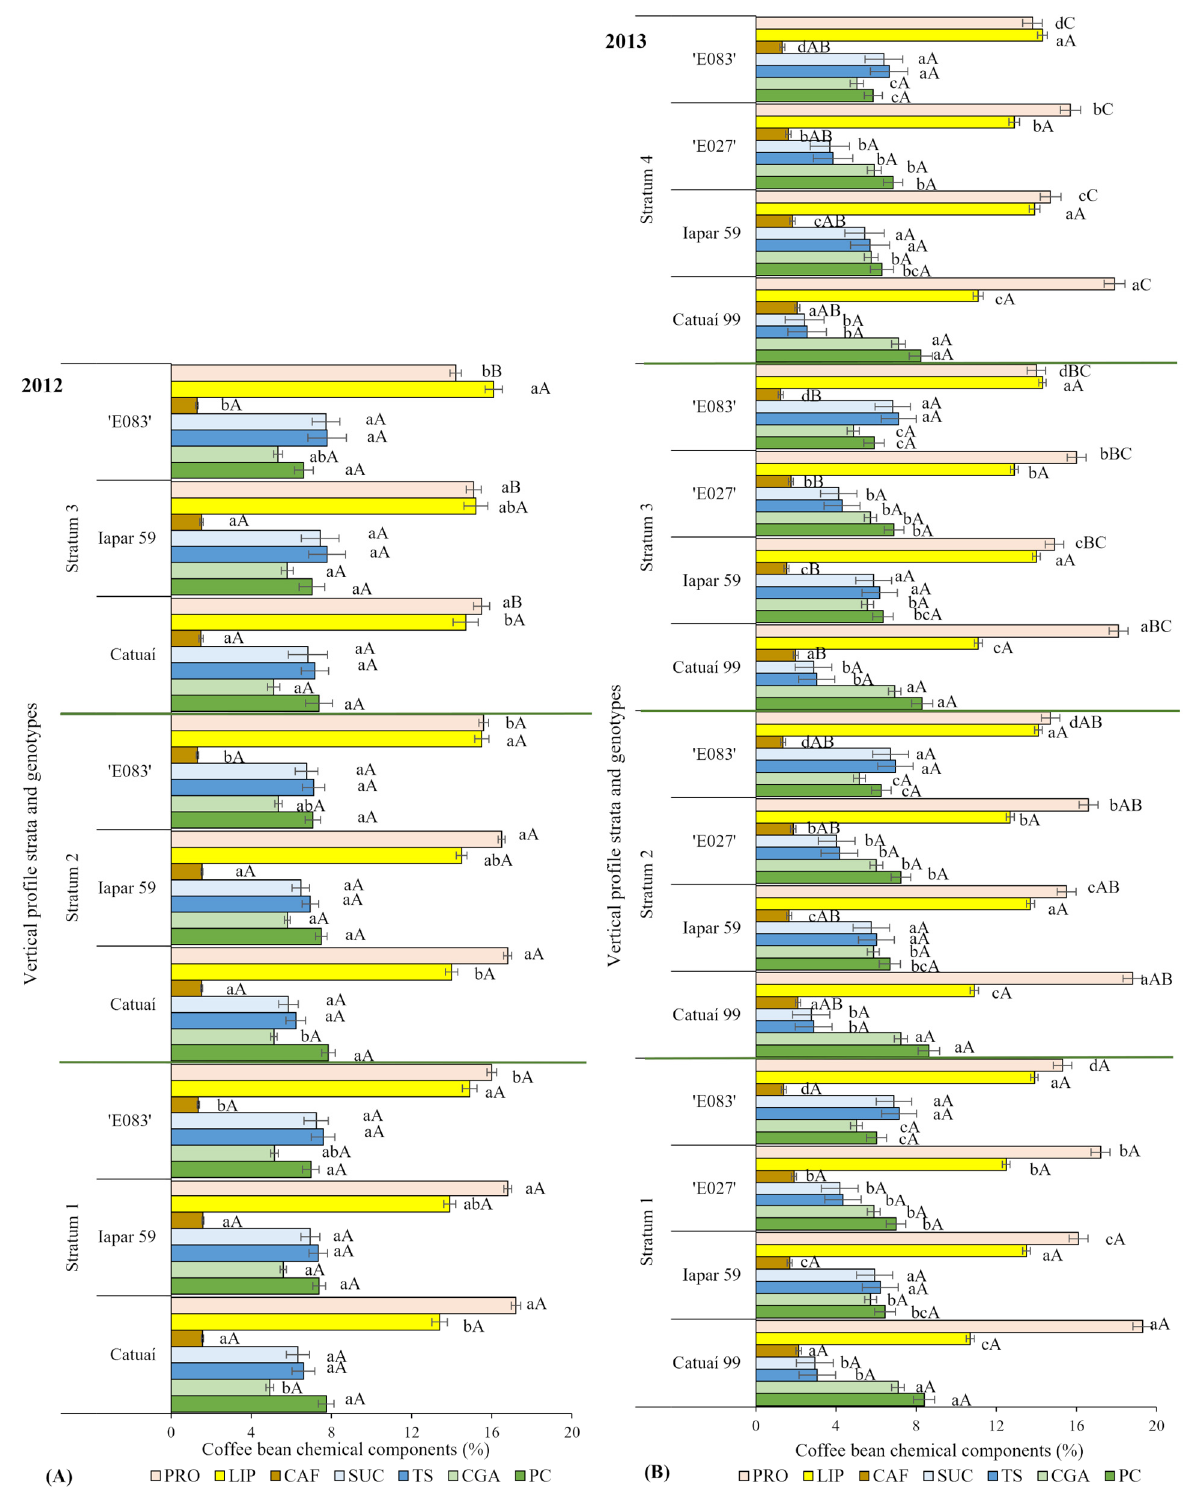
Figure 5. Chemical contents (% of dry matter) of coffee grains: PRO (proteins), LIP (lipids), CAF (caffeine), SUC (sucrose), TS (total soluble sugars), CGA (total chlorogenic acids), PC (phenolic compounds) of two harvests, ( A ) 2012 and ( B ) 2013, analyzed in four genotypes of Coffea arabica among the plant canopy strata (S1: 20–60 cm; S2: 61–100 cm; S3: 101–140 cm; S4: >140 cm). Estimated means ± standard error ( n = 2–4) are shown. Lower ‐ case letters compare genotype effects in each stratum, whilst the upper ‐ case letters compare stratum effects in each genotype.